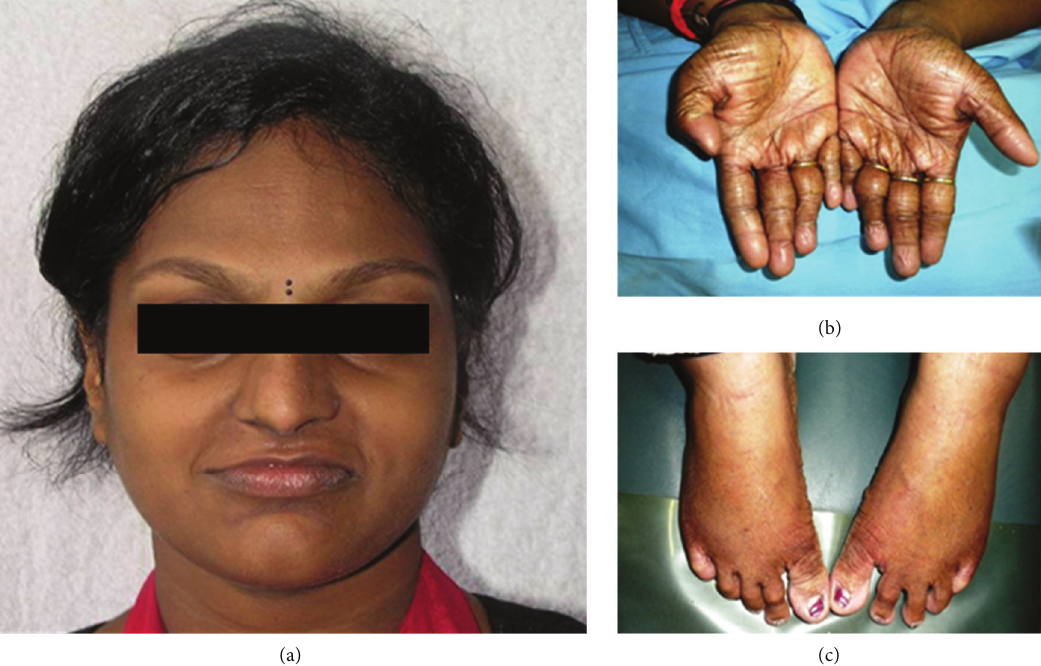
Figure 3: The patient exhibiting prominent and protuberant lips, abnormal hair (trichodysplasia) (head and eyebrows) (a), dry wrinkled skin of the palm (b), and feet with abnormal nails (onychodysplasia) (c).